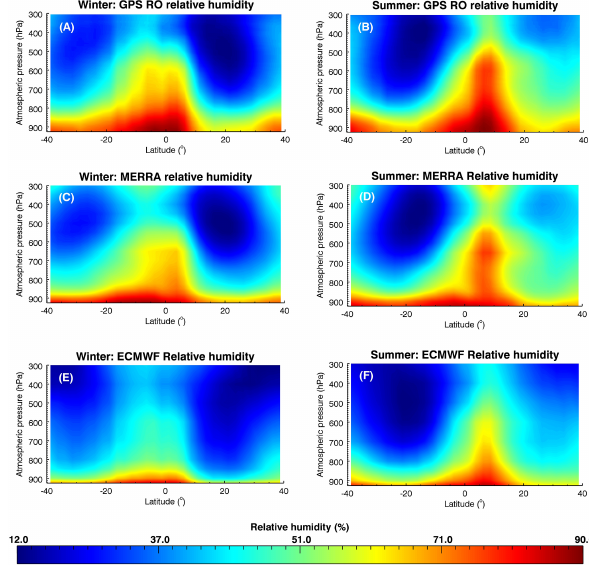
Figure 1. Pressure–latitude cross sections of relative humidity dur- ing winter (DJF; left column) and summer (JJA; right column) sea- sons averaged over the 2007–2009 period using GPSRO ( a and b ) observations and MERRA ( c and d ) and ECMWF ( e and f ) re-